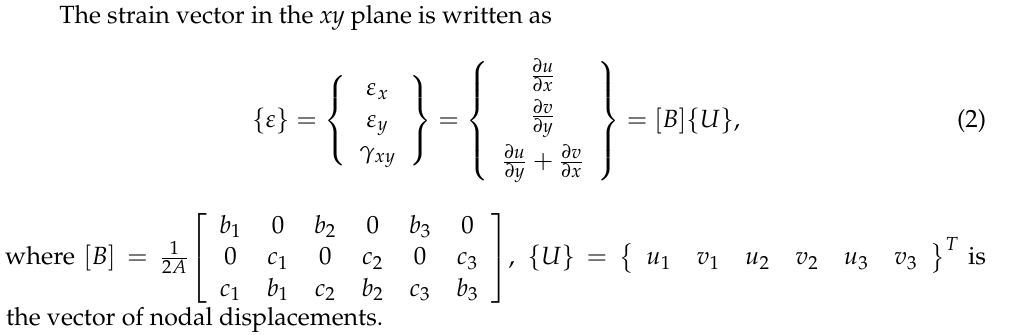
Figure 3. One-dimensional two-node FE for modeling the steel shell. Coefficients a 2 , b 2 , c 2 , a 3 , b 3 , c 3 are determined by cyclically changing the indices 1 → 2 → 3 →